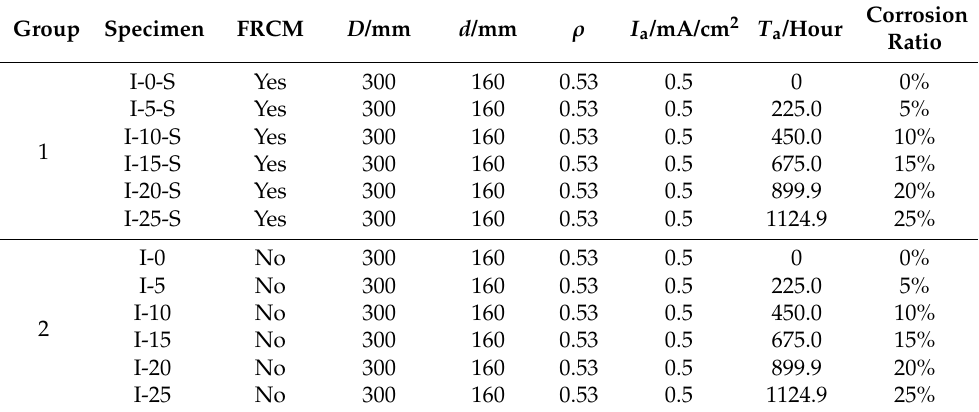
Table 1. Details of axial compression